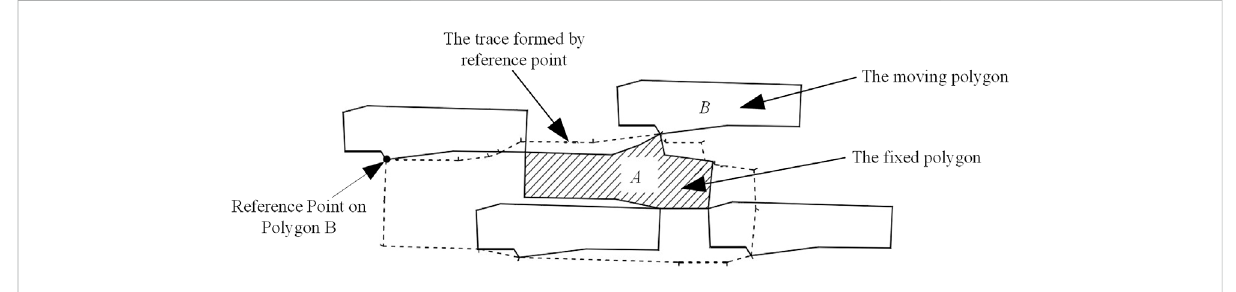
FIGURE 7 The process of solving NFP of two